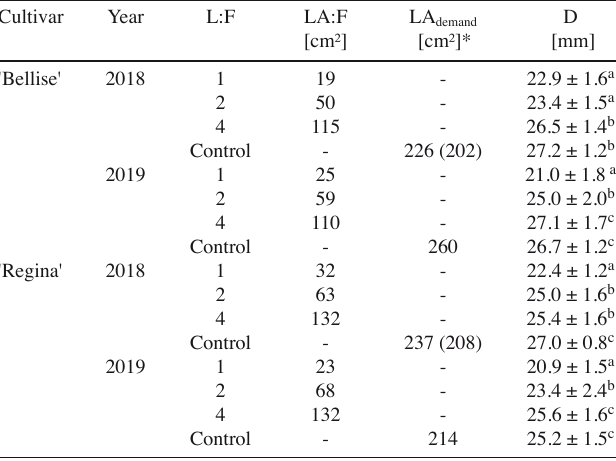
Tab. 2: Diameter of cherries (D) grown at adjusted leaf to fruit ratios (L:F) on girdled branches (n=18) and corresponding leaf area to fruit ra- tio (LA:F) measured in the laboratory; and leaf area demand per fruit (LA demand ), estimated for crop found in untreated trees (control, n=30), see Fig. 6.